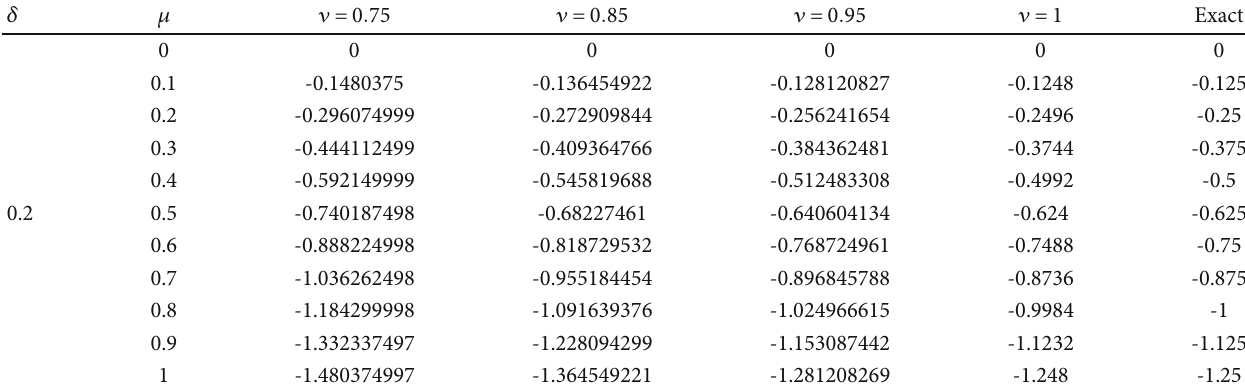
Table 1: Solution for the fi rst three approximations with exact solution, with mesh points δ = 0 : 2 , for equation